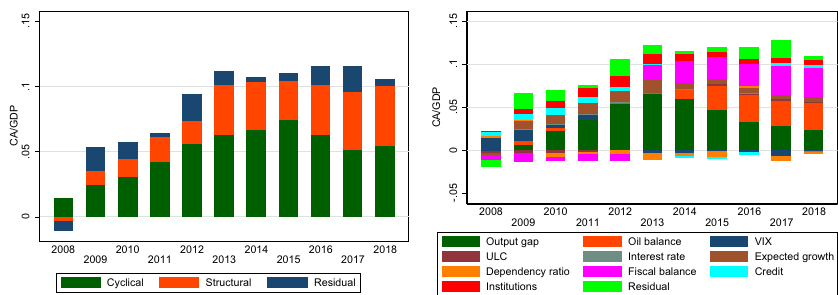
Fig. 10 Accumulated correction of the Spanish current account: extension to 2018. Notes. The left panel plots the cyclical and structural components of the Spanish current account 2008–2018 adjustment together with the accumulated residual term identified from Eq. (3). The right panel plots the detailed decomposition with the contribution of each of the regressors included in the analysis (oil balance also includes oil prices)